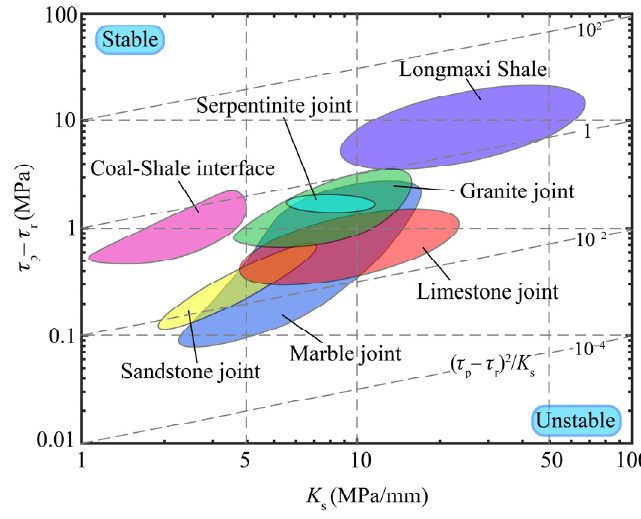
Figure 7. Fracture energy for intact rocks, rock joints, and interfaces.